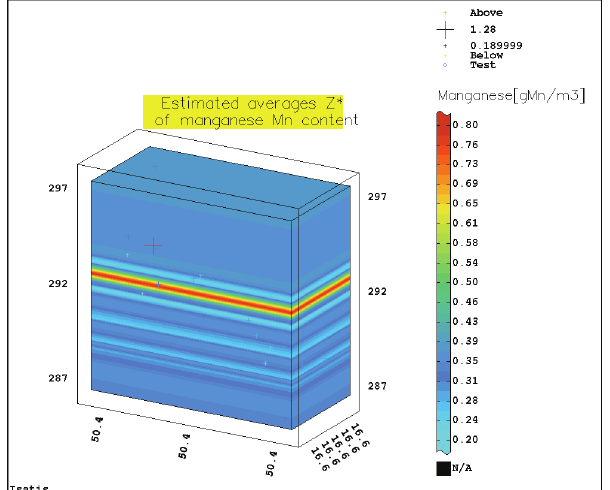
Fig. 23. Block diagram of estimated averages Z * distribution of iron Fe ++ content [gFe ++ /m 3 ] in underground water in Kłodzko intake area; 14 wells + 3 piezometers